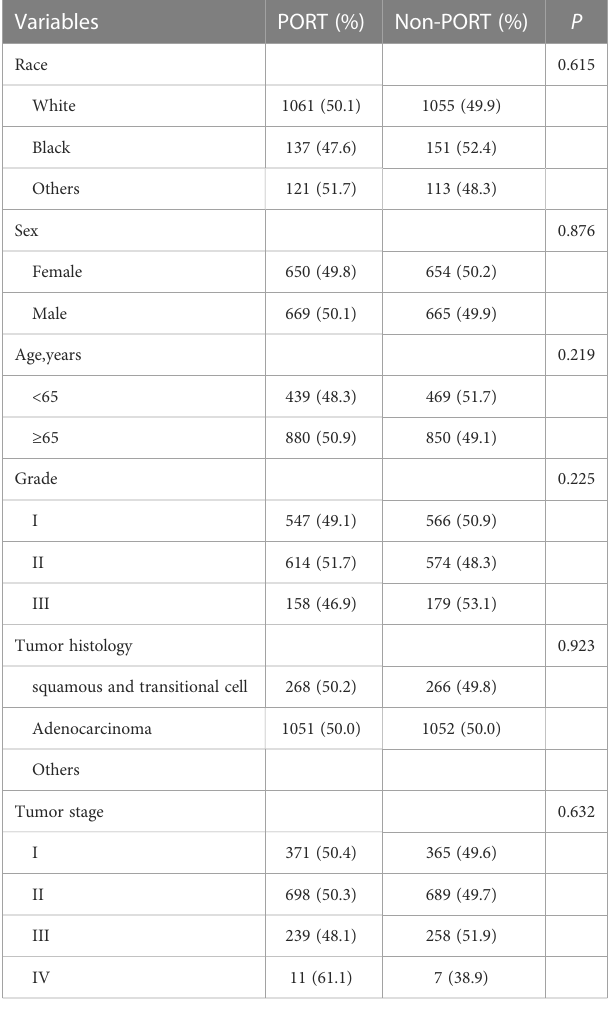
TABLE 1B Baseline Characteristics of Patients with IIIA-N2 NSCLC in right laterality of OS.